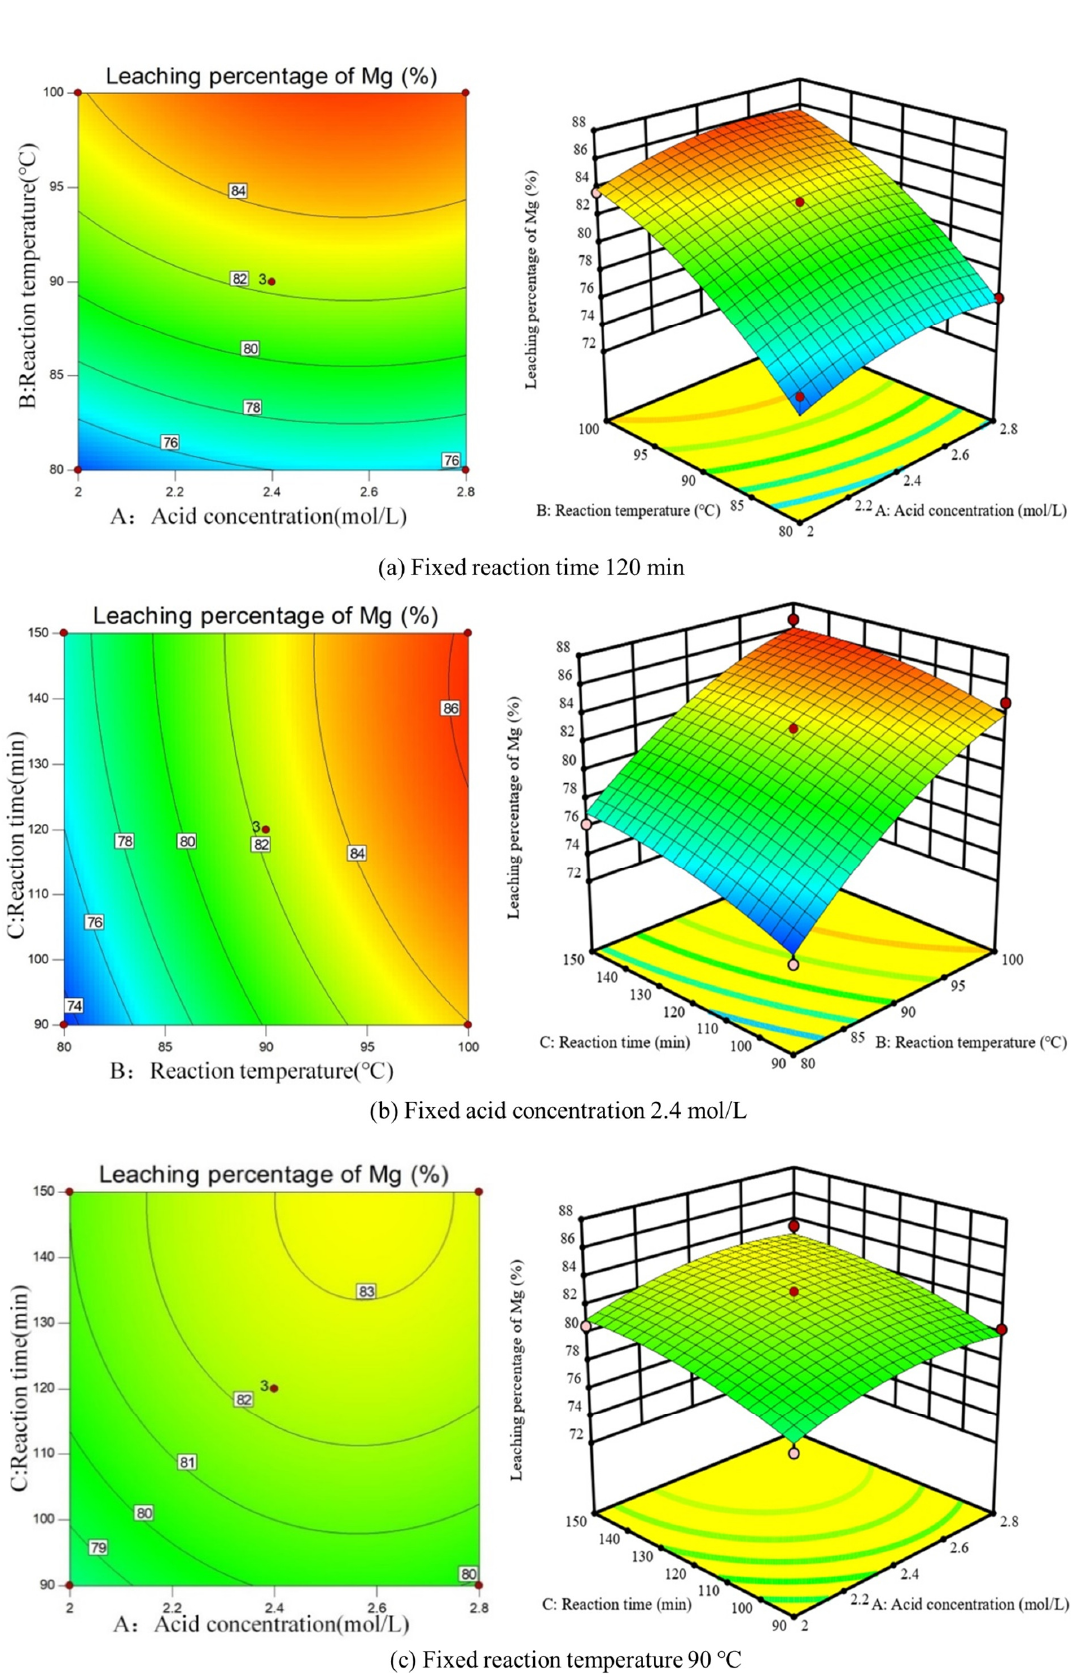
Figure 6. The 3D plots and contour plots showing the effect of ( a ) acid concentration and reaction temperature, ( b ) reaction temperature and reaction time, and ( c ) reaction time and acid concentration.